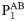
A directed graph representation of three-cycle exchange.The solid arcs represent the potential swaps, i.e. the two pairs (P1AB,D1B) and (P2B,D2A) can exchange their kidneys.